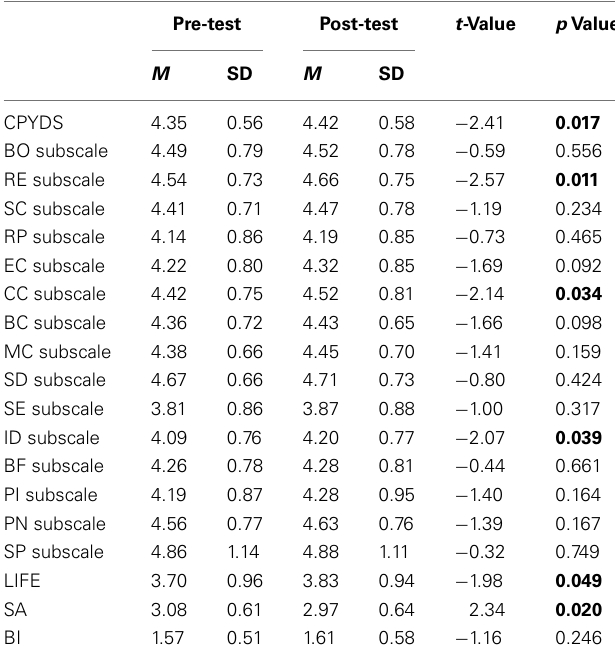
Table 7 | Changes in old participants based on the different objective indicators ( n = 192) .